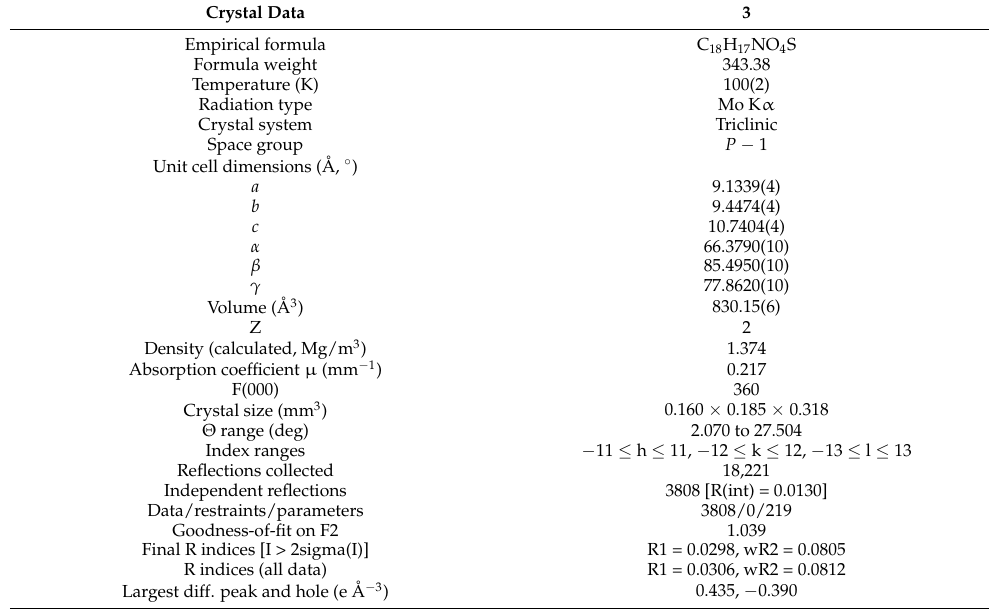
Table 1. Crystallographic data for structural analysis of compound 3